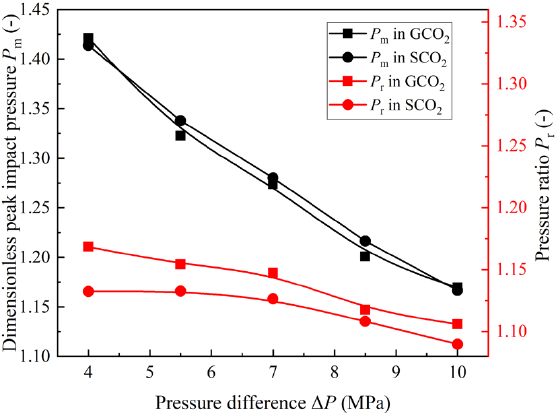
Figure 6. Variations of dimensionless peak impact pressure and pressure ratio with increasing pressure difference. Experimental conditions: Δ P = 4–10 MPa, 7 ≤ L c / D ≤ 9, and P a = 6 or 8.5 MPa. pressure difference. Experimental conditions: ∆ P = 4–10 MPa, 7 ≤ L c / D ≤ 9, and P a = 6 or 8.5